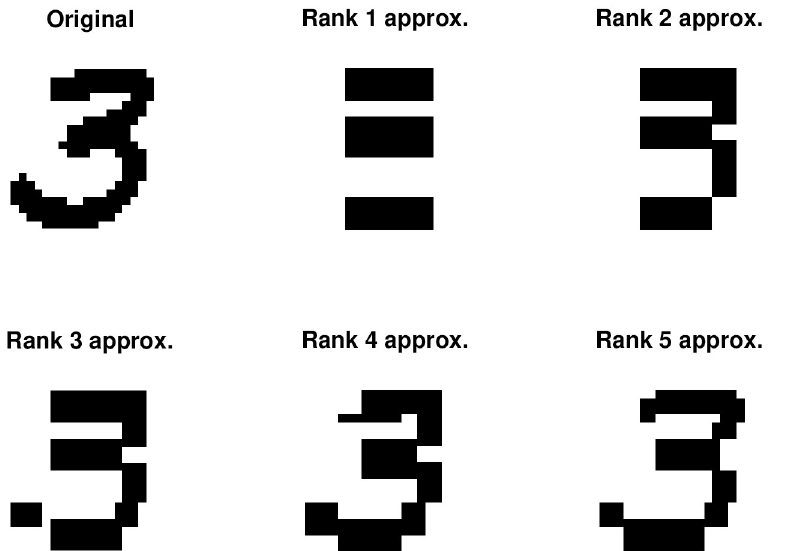
Fig 1. Binary low rank approximation to MNIST digit using DA+ALS BMF.